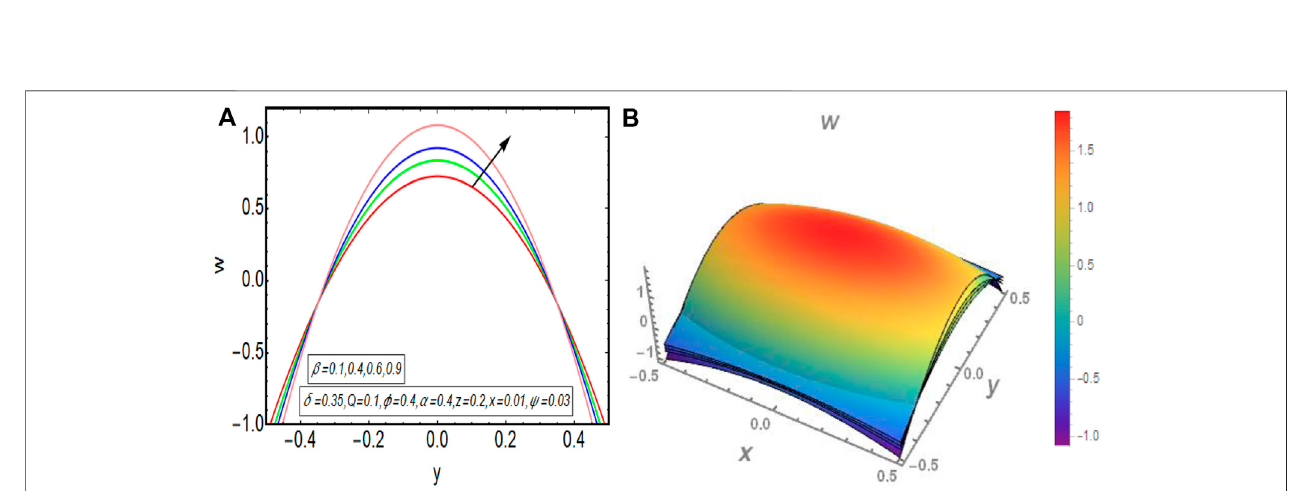
FIGURE 3 | (A) 2D-velocity plot for flowrate . (B) 3D-velocity plot for flowrate .